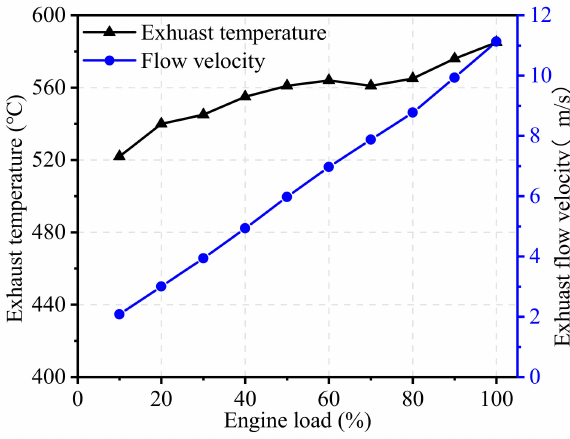
Figure 10. E ff ect of engine load on exhaust temperature and flow velocity.